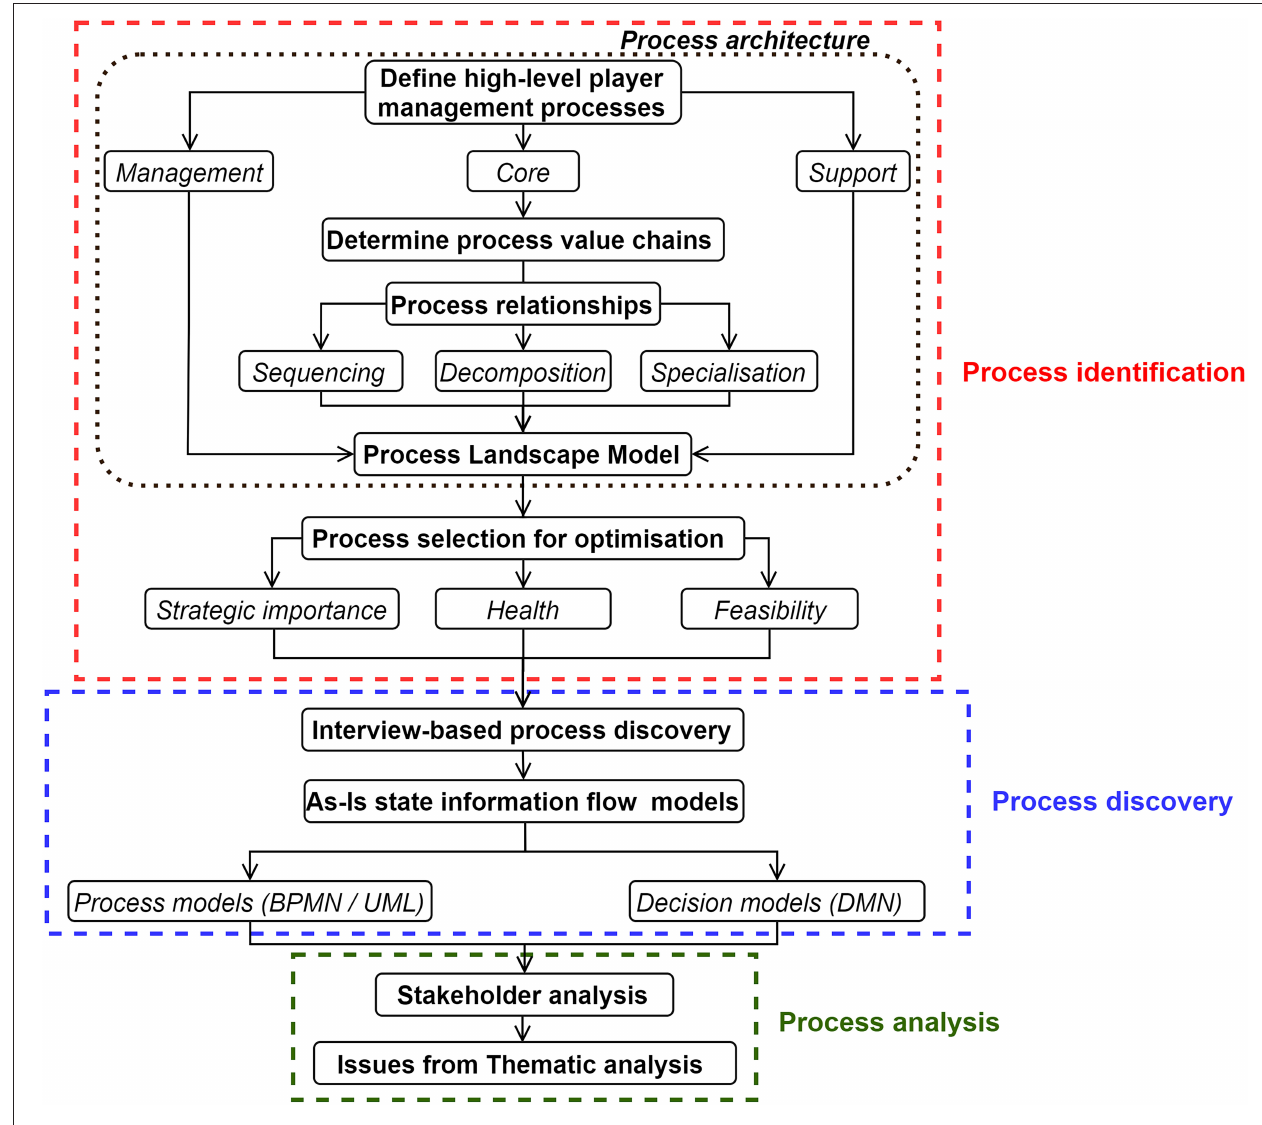
FIGURE 1 | Steps to identify the current issues in the player management information flow.